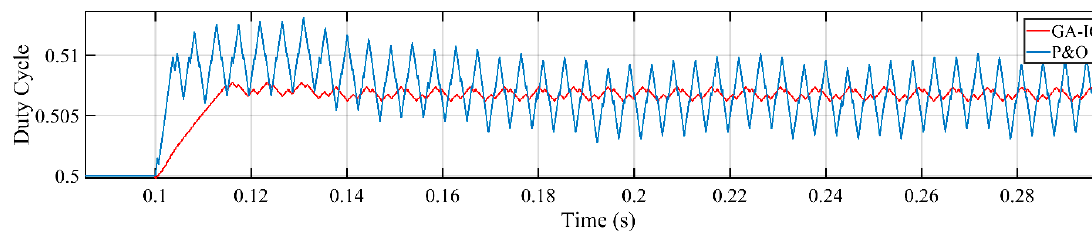
Figure 31. Case 3 duty cycle, detailed comparison of modified GA-IC vs. P&O.